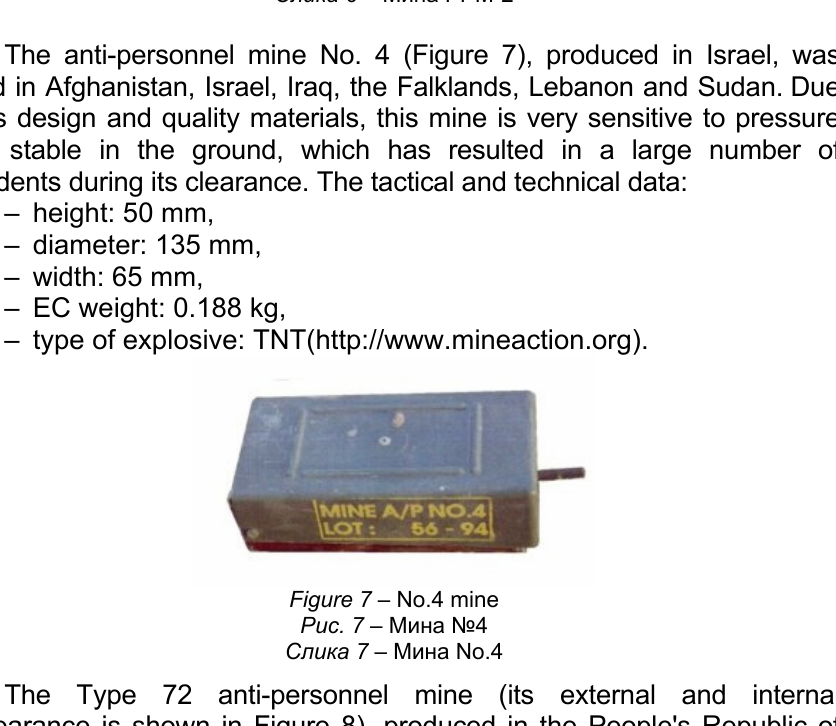
Figure 6 – PPM-2 mine Рис . 6 – Мина PPM-2 Слика 6 – Мина PPM-2